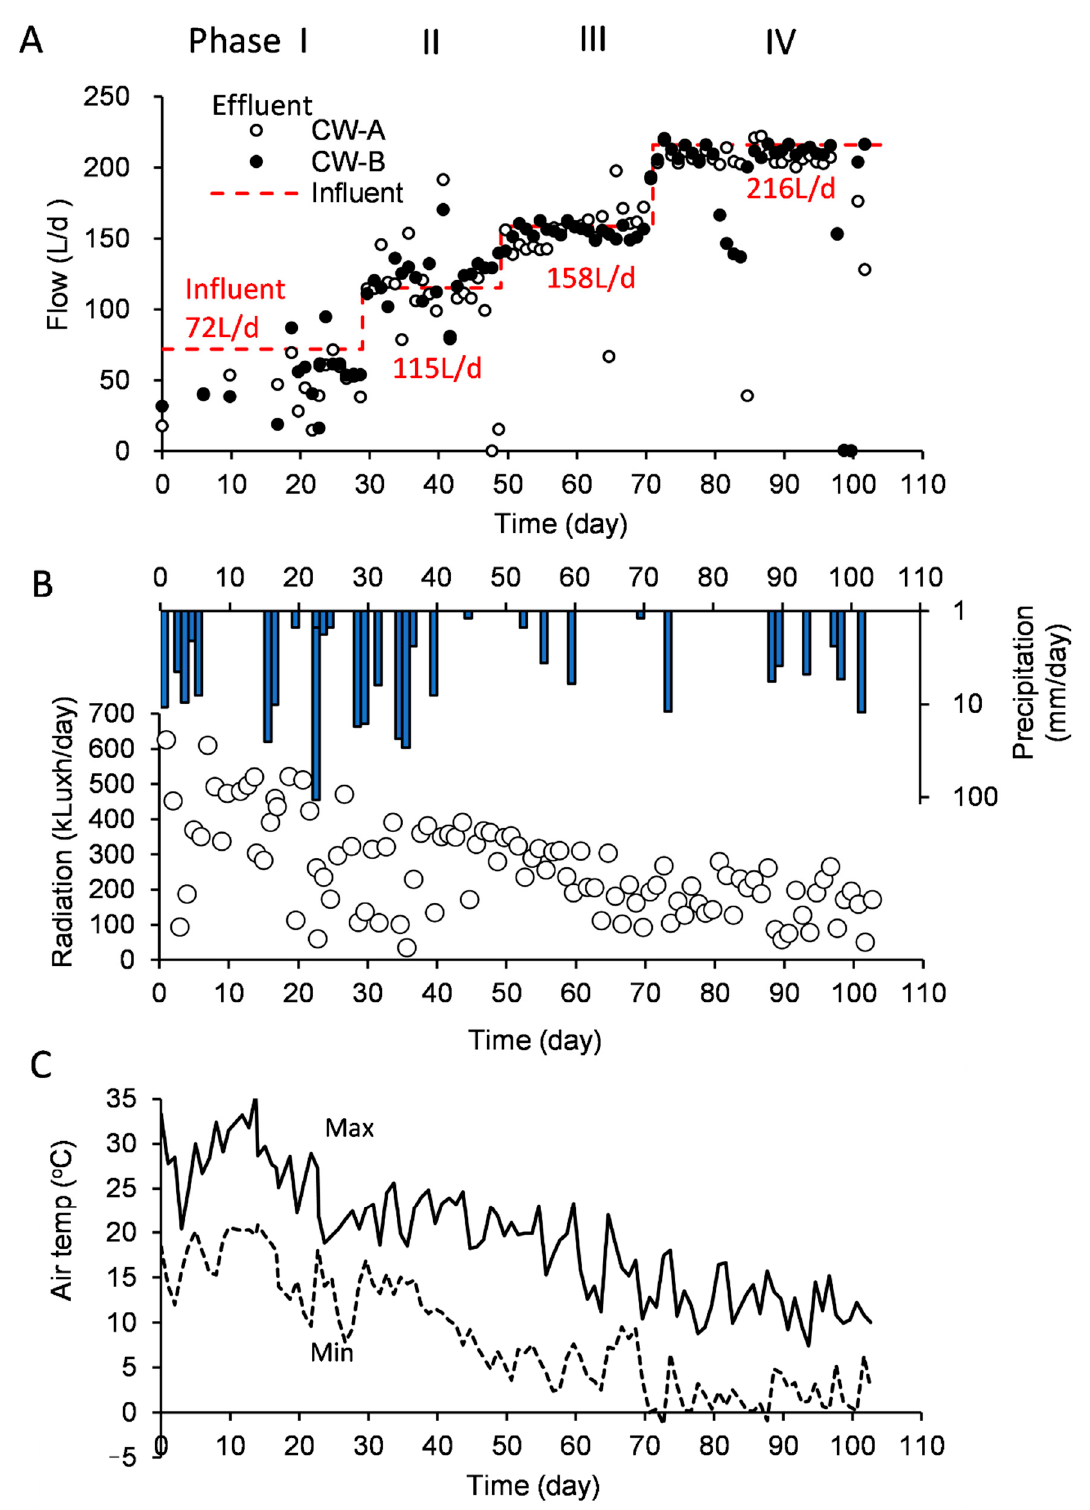
Figure 2. Experiment conditions for treating NMD by pilot-scale CWs at A-Mine. Flow rates of the CWs: ( A ) solar radiation and precipitation ( B ) and air temperature ( C ). Eighteenth September 2019 was defined as day 0.